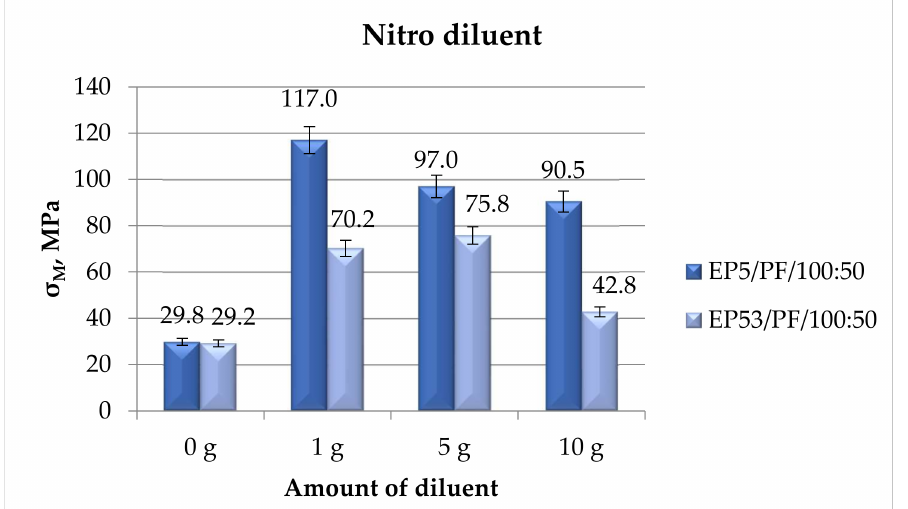
Figure 12. Compressive strength calculated for Epidian 5 and Epidian 53 epoxy compounds as a function of the amount of nitro